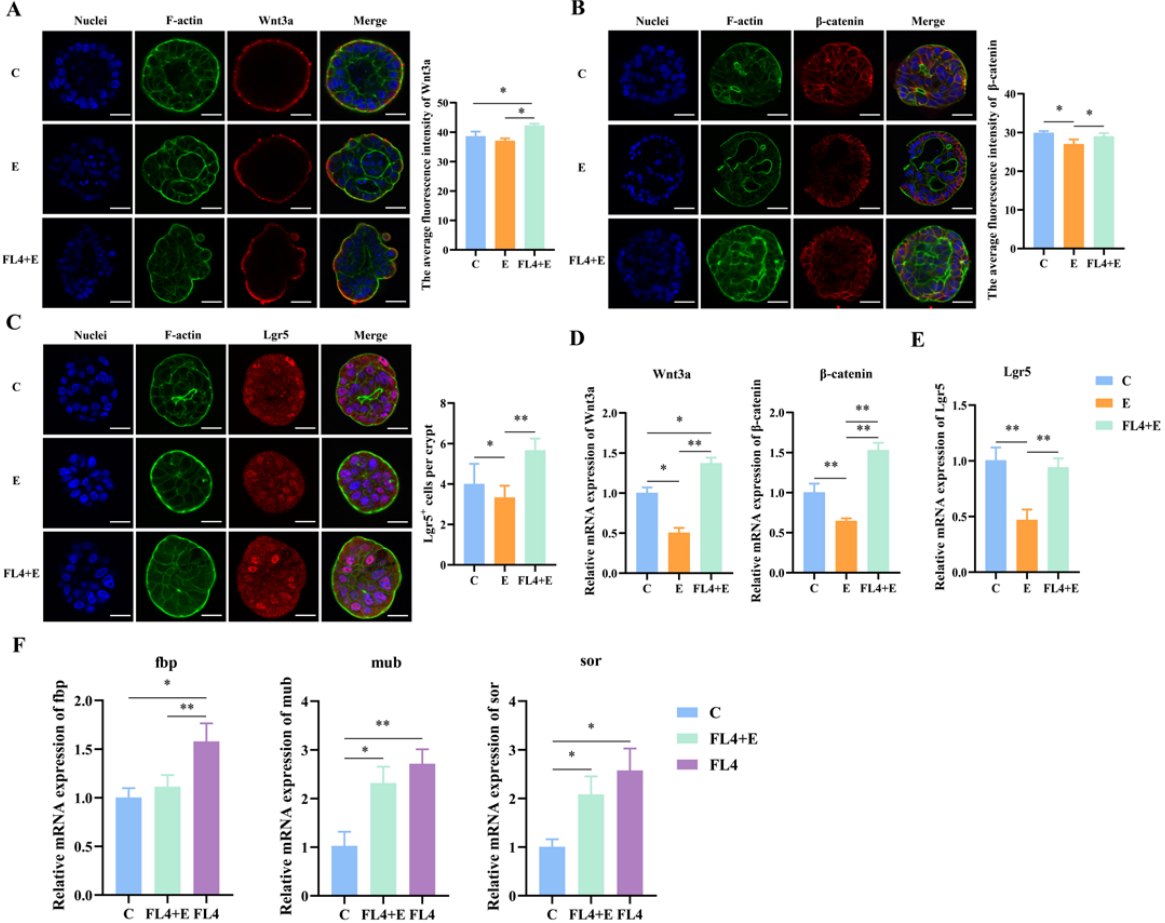
Figure 9. L. fermentum FL4 enhanced ISC regeneration by moderately activating the Wnt/ β -catenin pathway. ( A , B ) Apical-out organoids were stained with Wnt3a and β -catenin (red). Nuclei were stained with 4 ′ ,6-diamidino-2-phenylindole (DAPI, blue), cytoskeletons were stained with F-actin (green). Scale bars, 20 µm. ( C ) Basal- out organoids were stained with Lgr5 (red). Nuclei were stained with 4 ′ ,6-diamidino-2-phenylindole (DAPI, blue), cytoskeletons were stained with F-actin (green). Scale bars, 20 µm. ( D , E ) RT-qPCR analysis of the Wnt3a, β -catenin and Lgr5 in organoids, n = 3. ( F ) Relative expression of adhesion marker genes fbp, mub, sor, n = 3. * p < 0.05, ** p < 0.01. Expression of adhesion genes such as fbp ( p = 0.004), mub ( p = 0.004) and sor ( p = 0.026) was significantly increased both in groups of L. fermentum alone-treated and L. fer- mentum pretreated with ETEC K88 attack (Figure 9F), indicating that the adhesion of L. fermentum was less affected by ETEC K88 invasion. We speculated that the particular struc- ture of apical-out intestinal organoids provides the potential to enhance adhesion of pro- biotics to intestinal epithelial cells. 3.9. L. fermentum (FL4) Modulated ETEC K88- Induced Inflammatory Responses in the Intestinal Epithelium